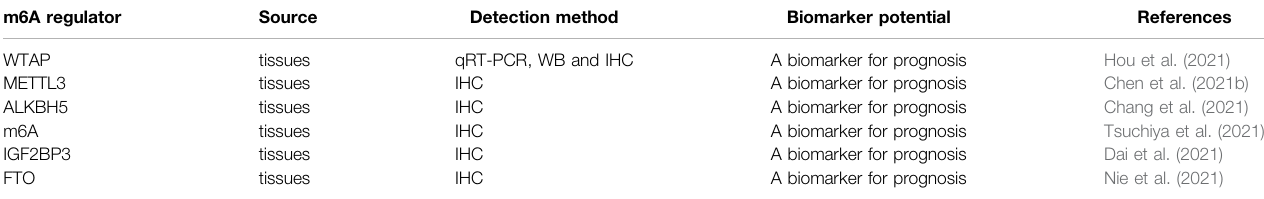
TABLE 2 | The potential of m6A as a diagnostic and prognostic tool in bladder